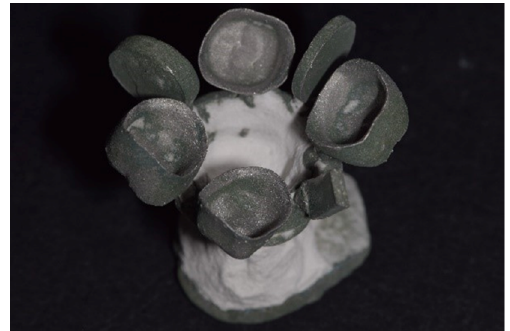
Figure 5. Divested cast samples.